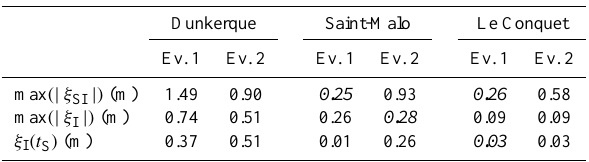
Fig. 6. Time series of the various components of the water elevation ξ at: Dunkerque (top), Saint-Malo (middle), Le Conquet (bottom), for the November 2007 (left) and March 2008 (right) events.